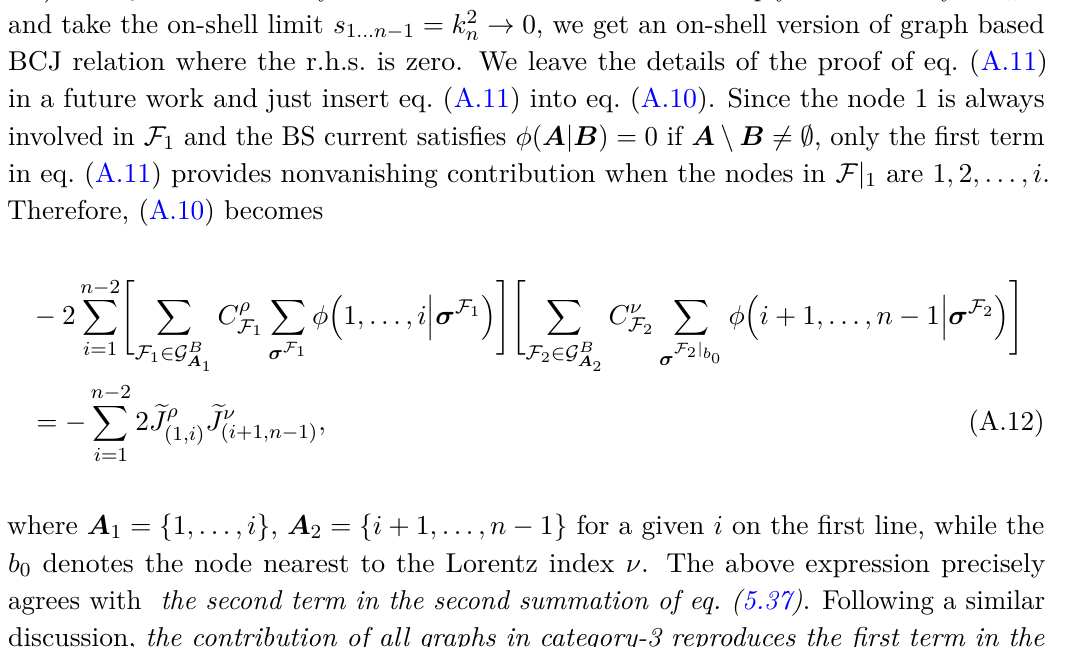
JHEP01(2022)162 . This 1